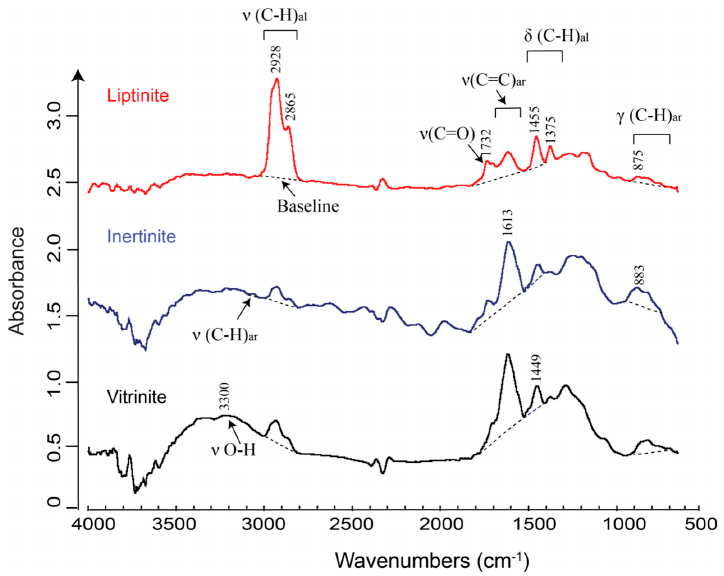
Figure 2. Micro-FTIR spectra of liptinite, vitrinite, and inertinite. Liptinite shows the strongest aliphatic CH x stretching signal and the most intense oxygenated group stretching at ~1710 cm − 1 , but the lowest intensities for C=C ring stretching at ~1600 cm − 1 , aromatic CH x stretching, and out-of-plane deformation. Dashed lines represent the linear baselines applied during the FTIR analysis. Note integrated areas of oxygenated and aromatic peak can be obtained by Fourier self-deconvolution [51] or curve-fitting of peaks in the ~1560–1800 cm − 1 region [26]. Note υ —stretching vibration; δ —deformation vibration in plane; γ —deformation vibration out of plane; subscript al—aliphatic; subscript ar—aromatic. The spectra of liptinite and inertinite have been moved up the vertical axis to avoid overlaps. Modified after figure 6 in Chen et al. [26] with copyright permission from Elsevier.